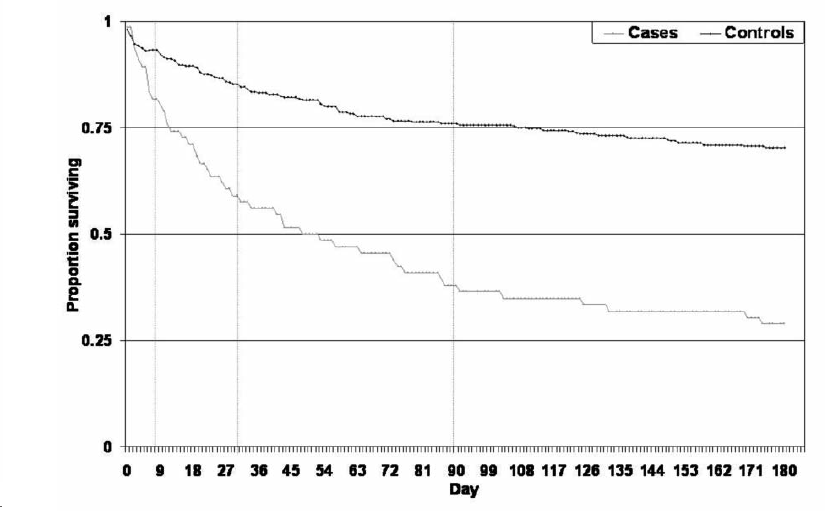
Figure 1. Flowchart of C. difficile cases Figure 2. Kaplan-Meier Plot of survival to 180 days for C. difficile infection cases and and those excluded. controls. * Calculated from day of first positive C. difficile test for cases and the time since reaching same point in admission for controls. Vertical lines are for days 7, 30 and 90. Table 1. Attributes of cases and